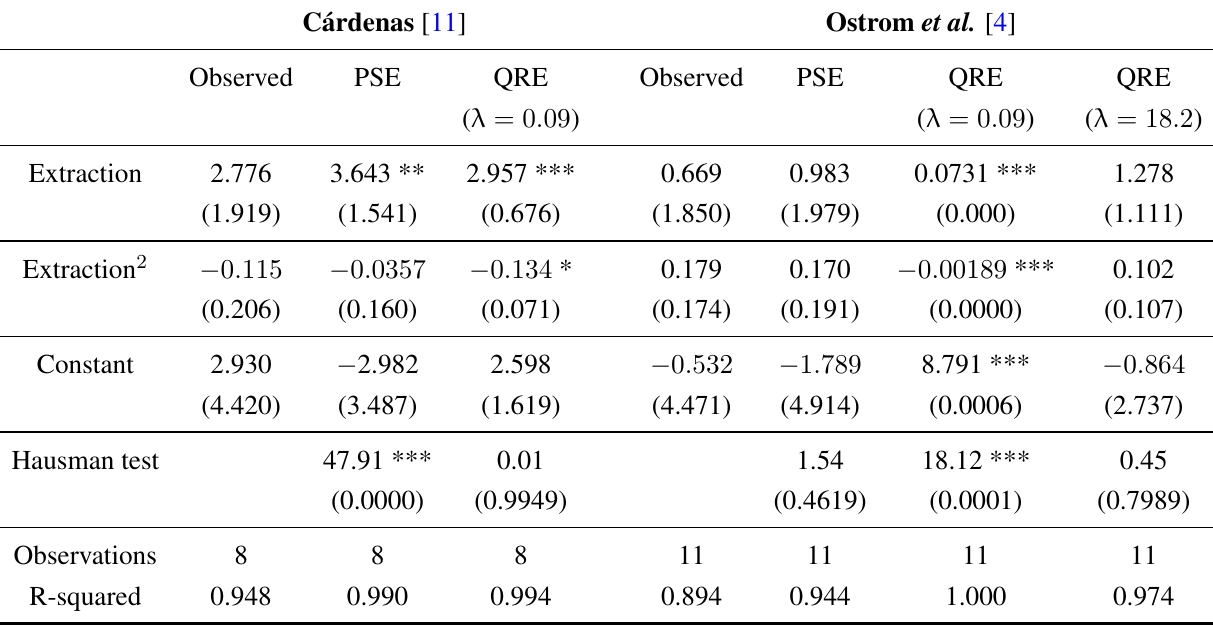
Table 4. OLS: observed/predicted percentage versus the second order polynomial for